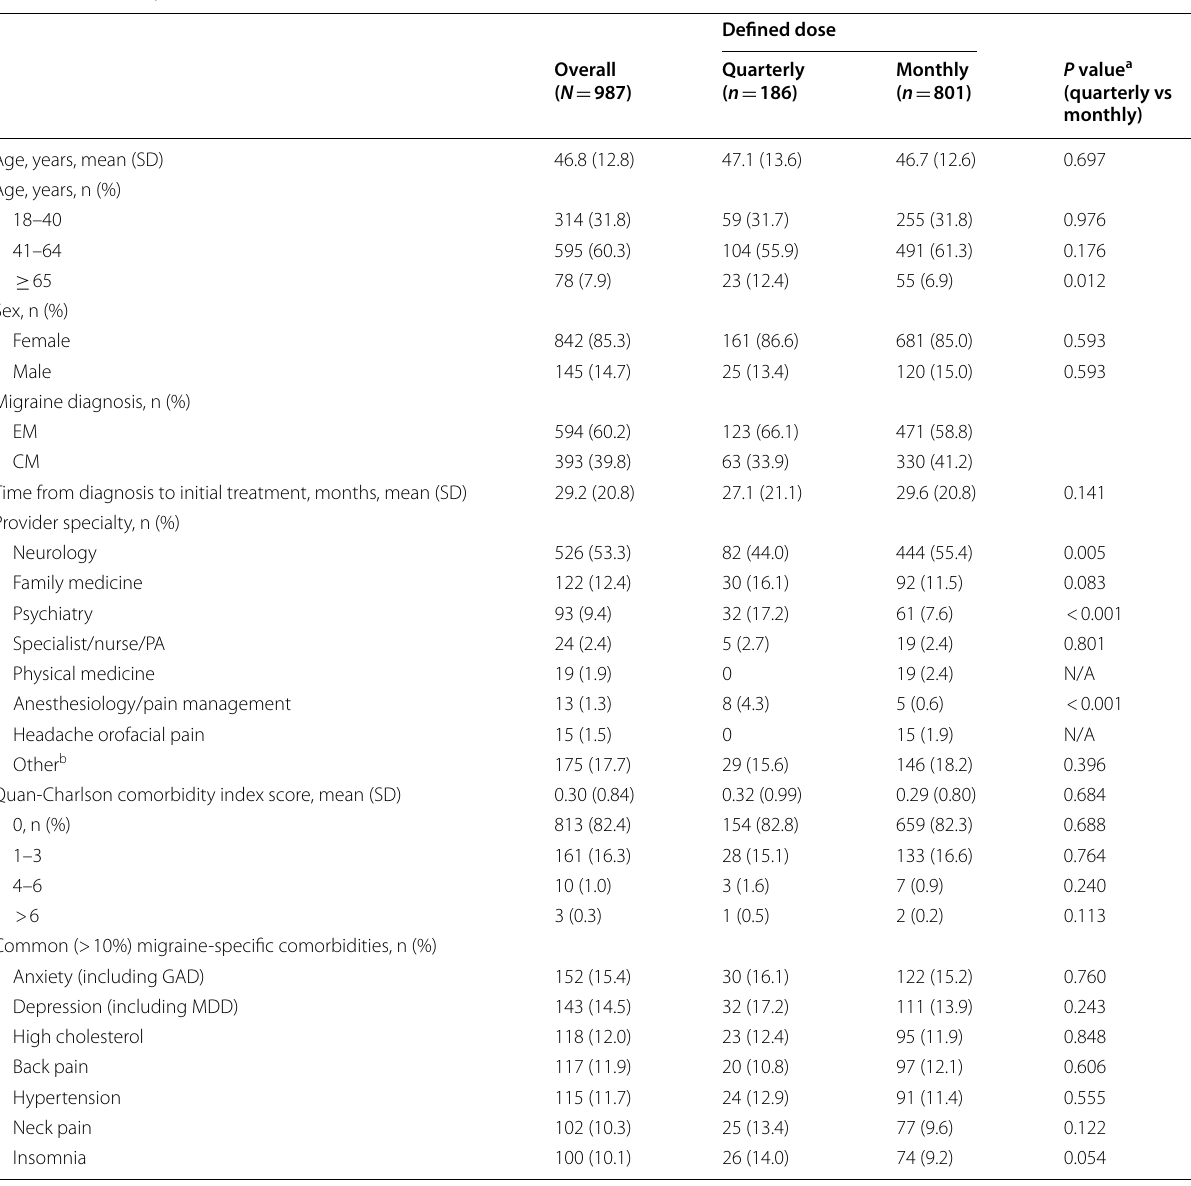
Table 1 Baseline patient